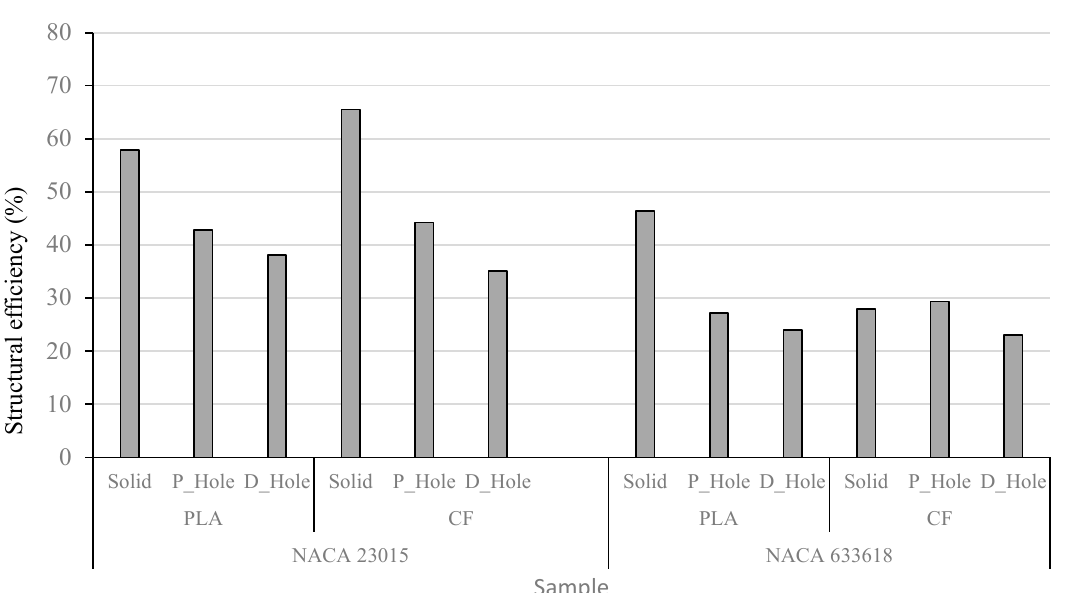
Figure 8. Comparison of structural efficiency values.